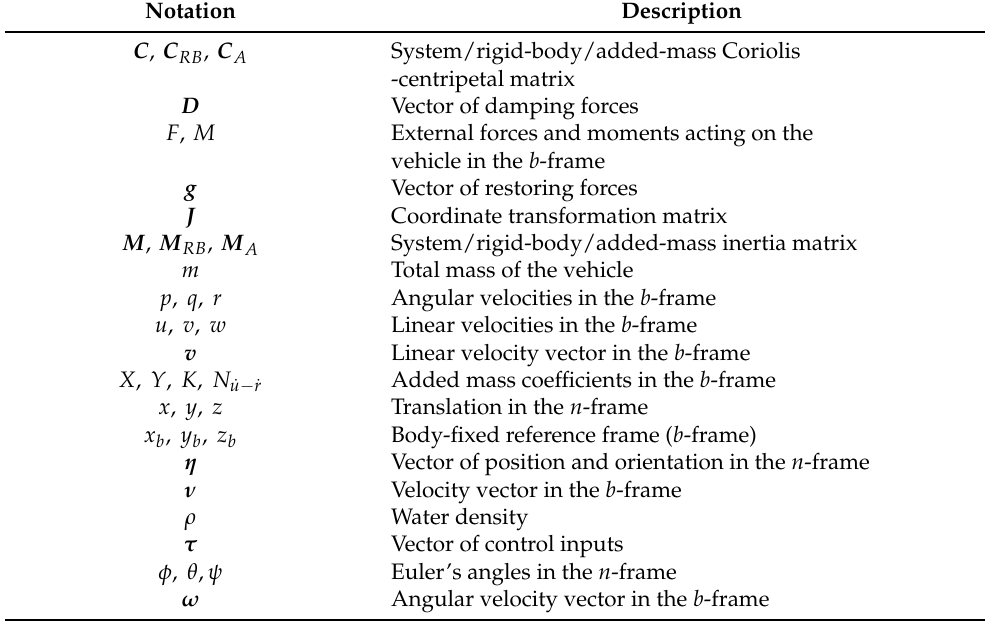
Table 3. Definitions of